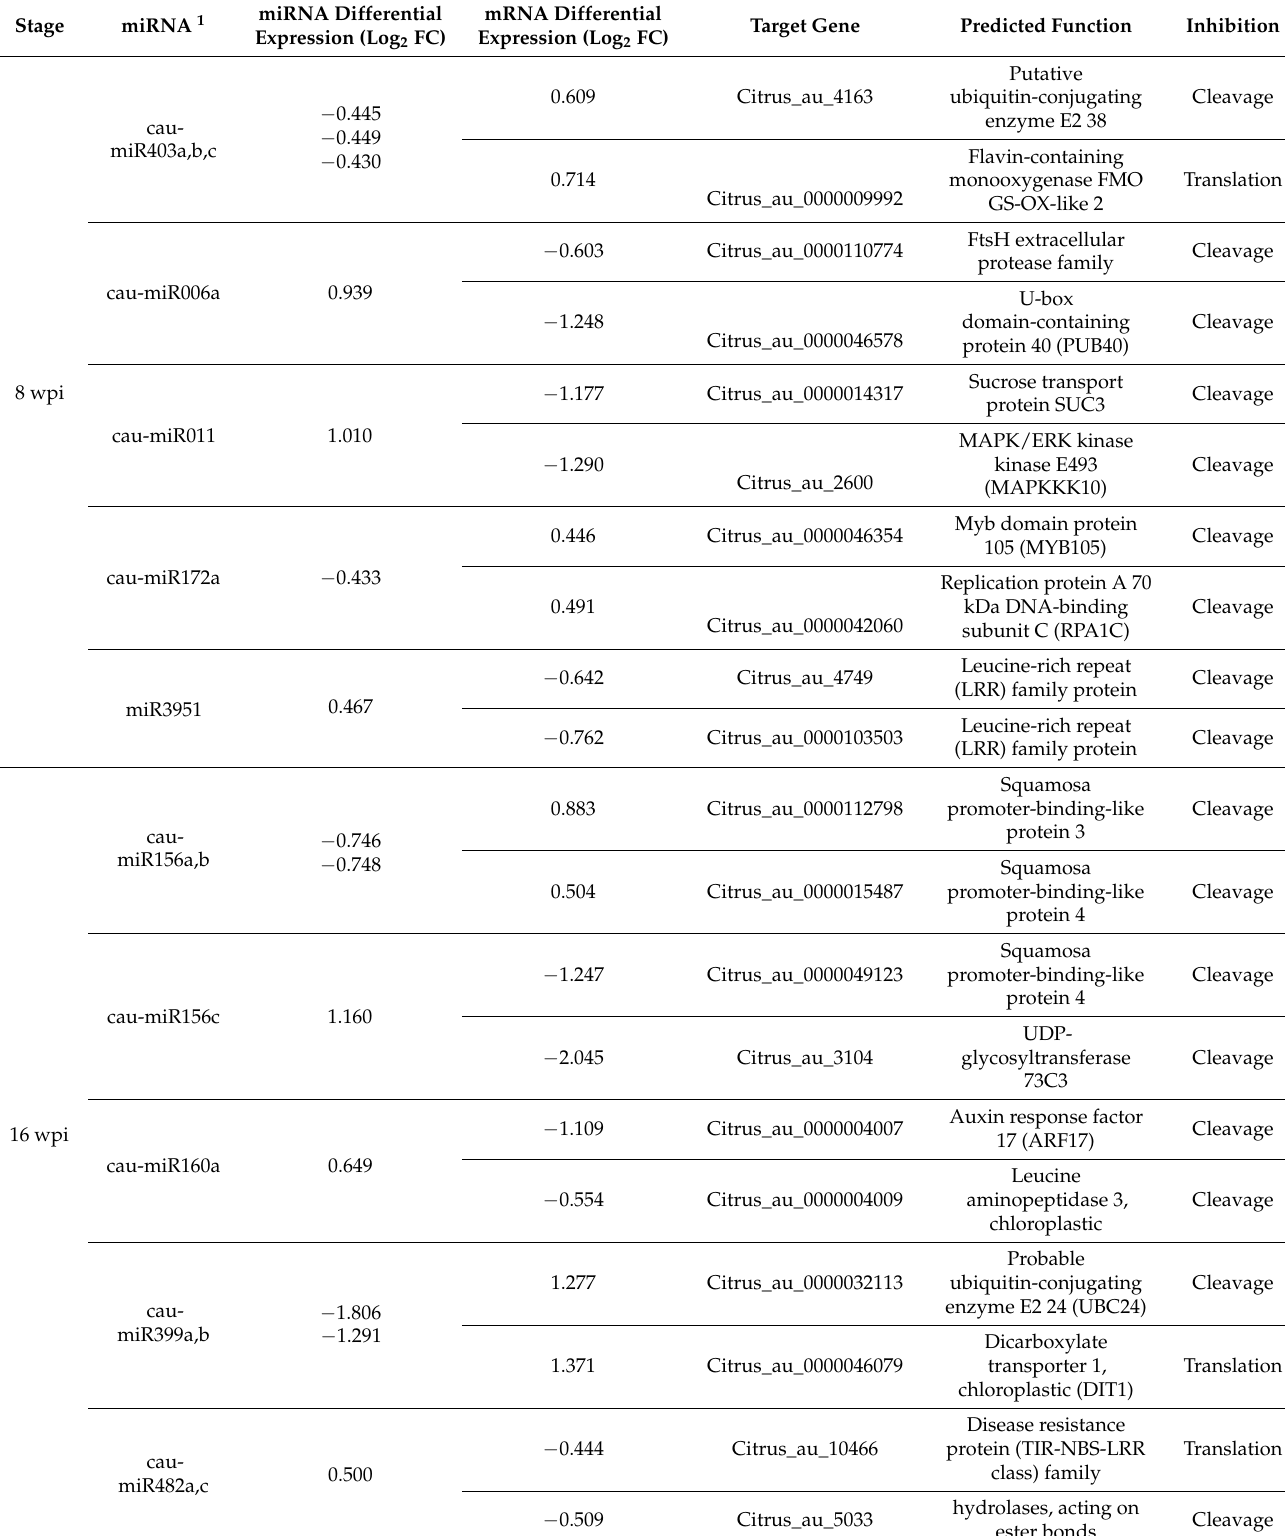
Table 3. Differential expression of miRNAs and their target genes in asymptomatic (early) and symptomatic (late) stages of Huanglongbing (HLB)